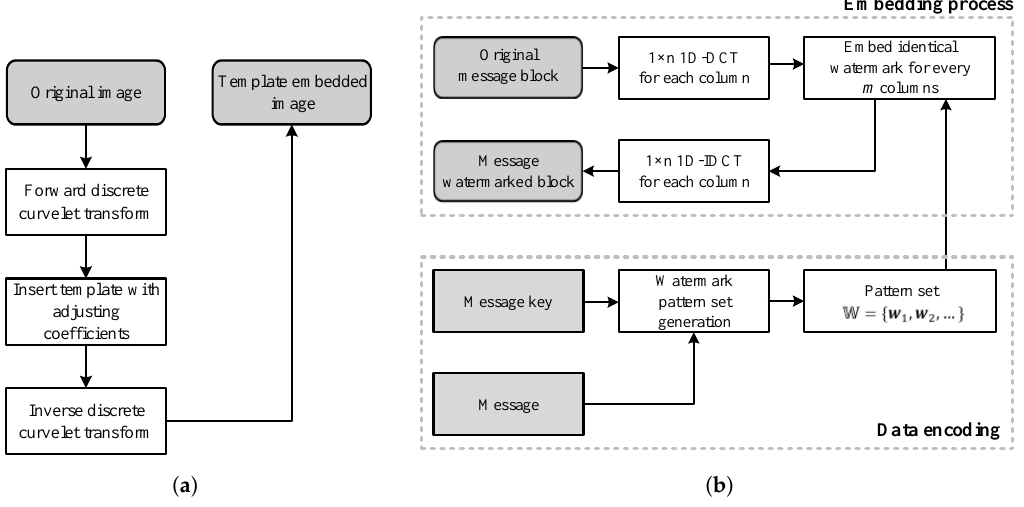
Figure 5. Detailed embedding process. ( a ) Template embedding process; ( b ) message watermark embedding process.